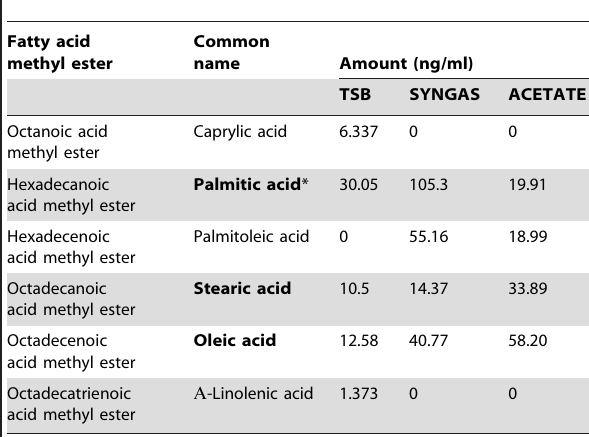
Table 1. Results of FAME analysis.